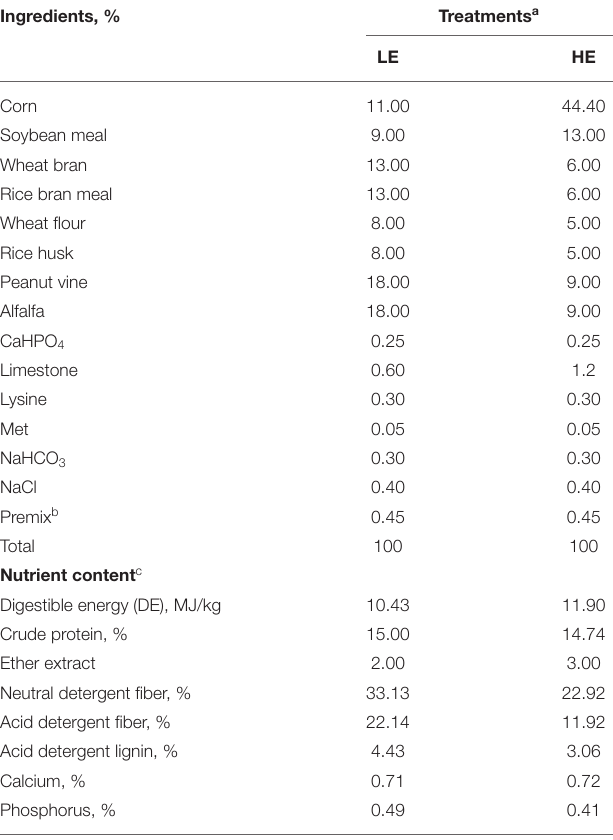
TABLE 1 | Experimental diet composition and nutrient levels. Ingredients,